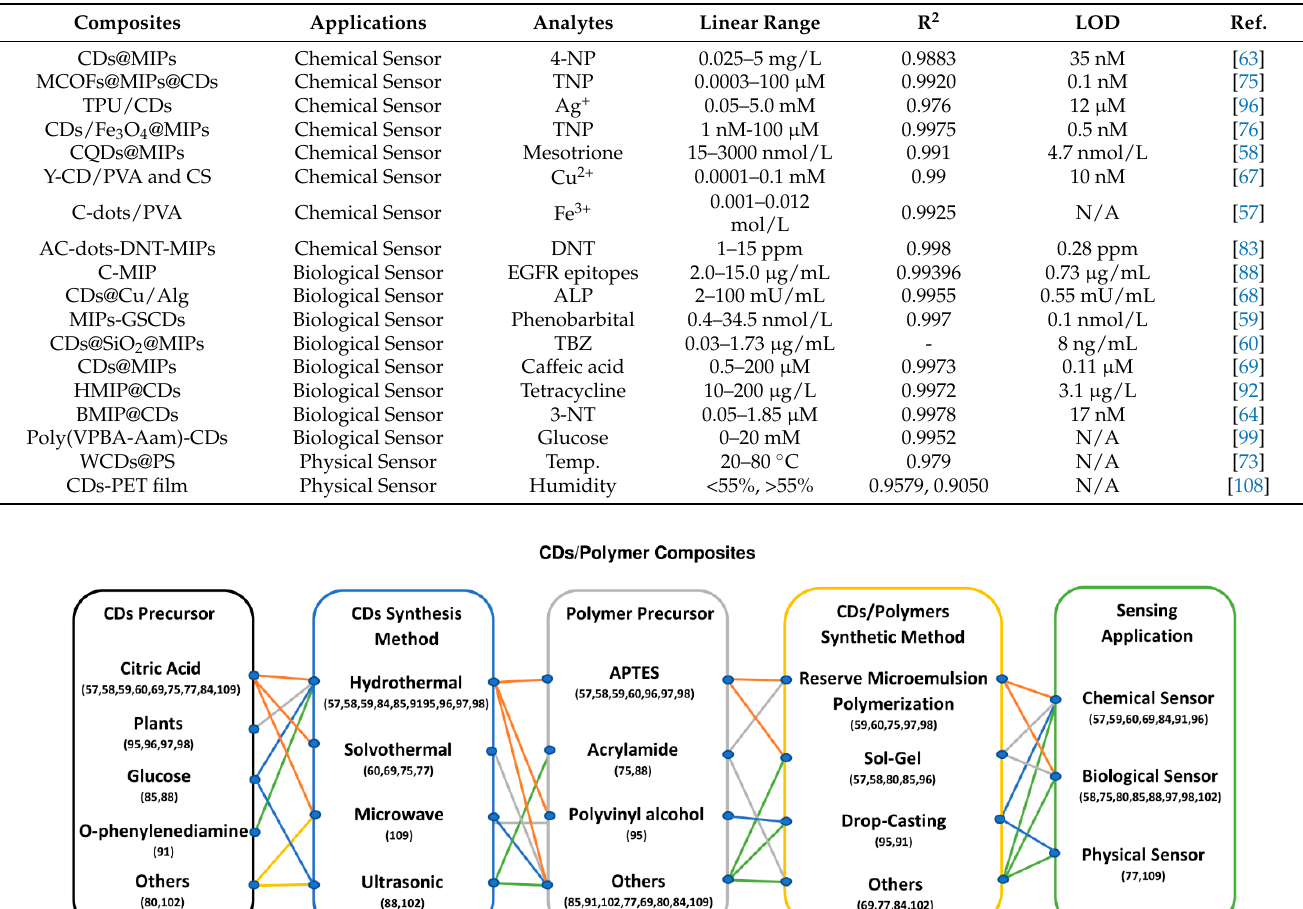
Table 4. Several sensing applications of CD/polymer composites and their sensing performances.